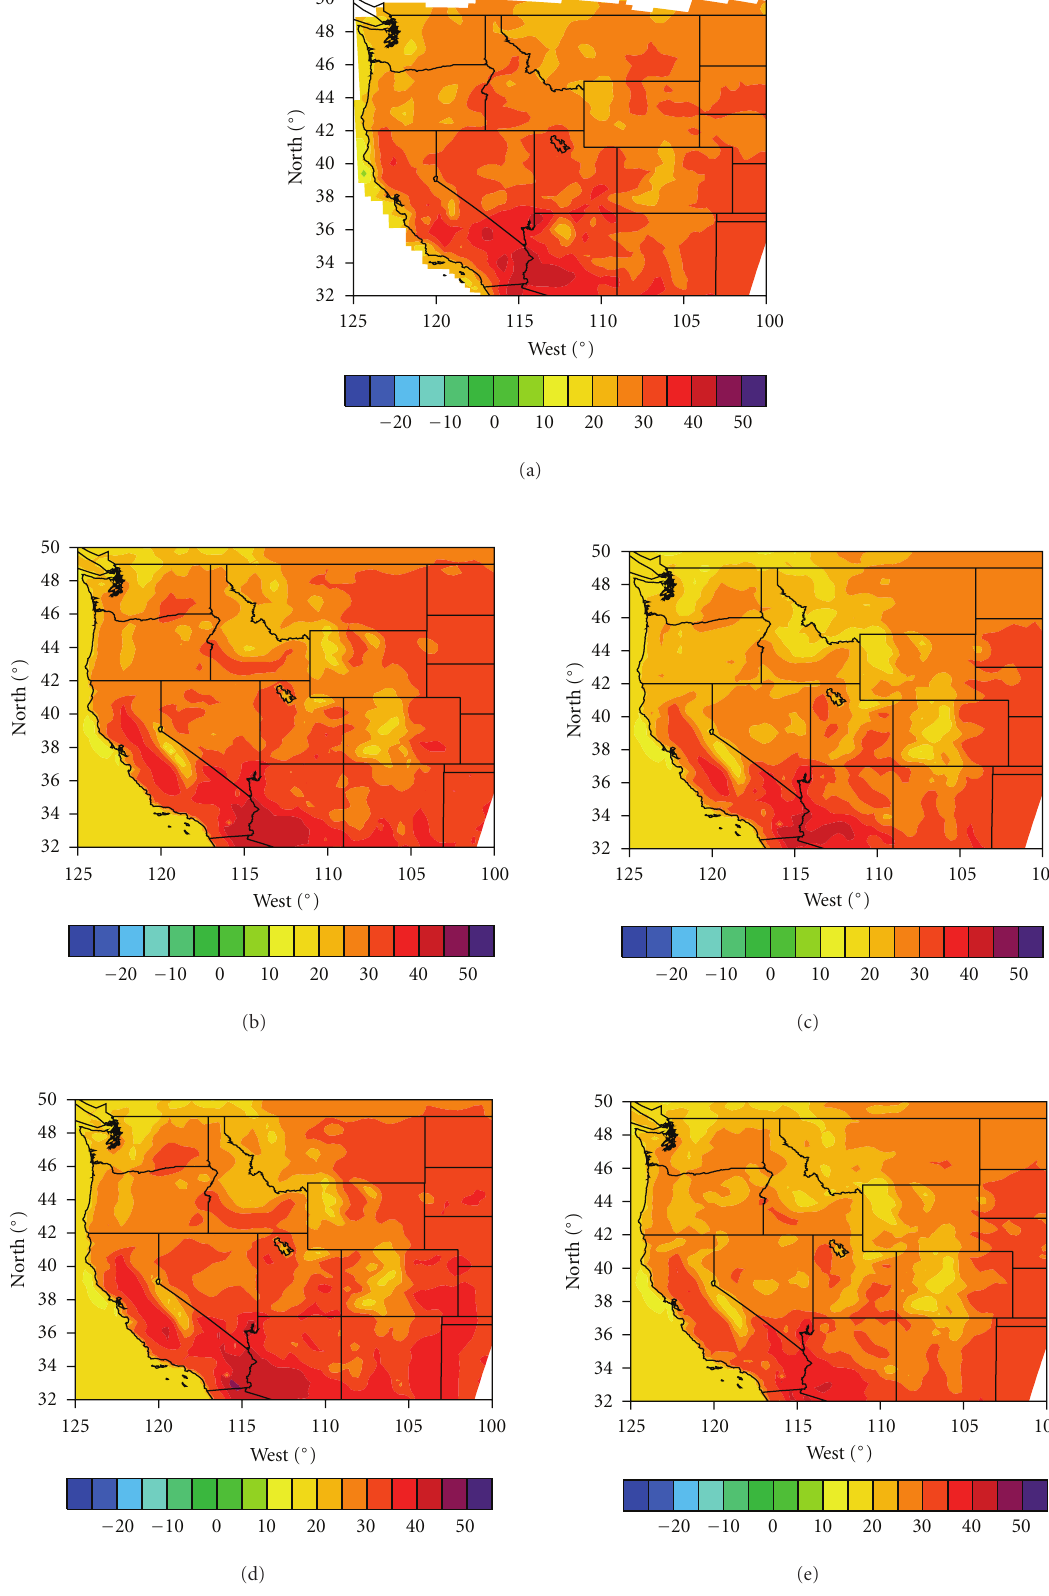
Figure 6: The geographic distribution of observed and WRF-simulated summer (June, July, and August) daily maximum temperature (Unit: ◦ C). (a) Observations; (b) CLM3; (c) Noah; (d) RUC; (e)